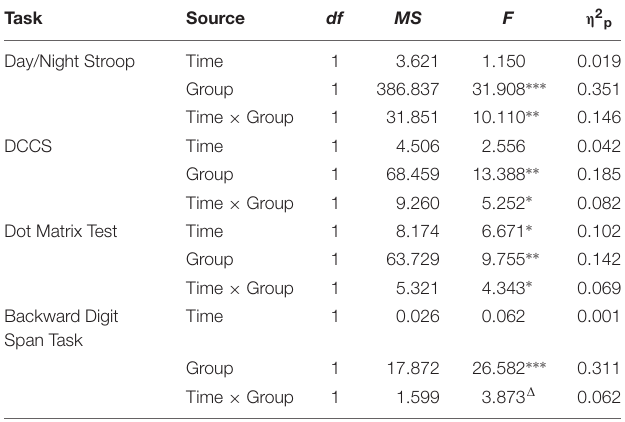
TABLE 9 | Music training after-effect repeated measurement analysis of